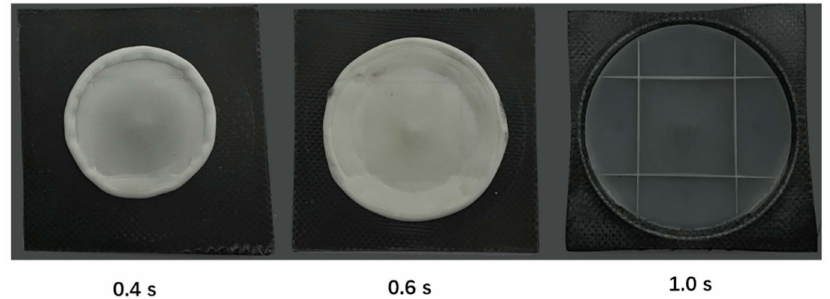
Figure 18. Side views of compression flow front at 0.4 s, 0.6 s, and 1.0 s.